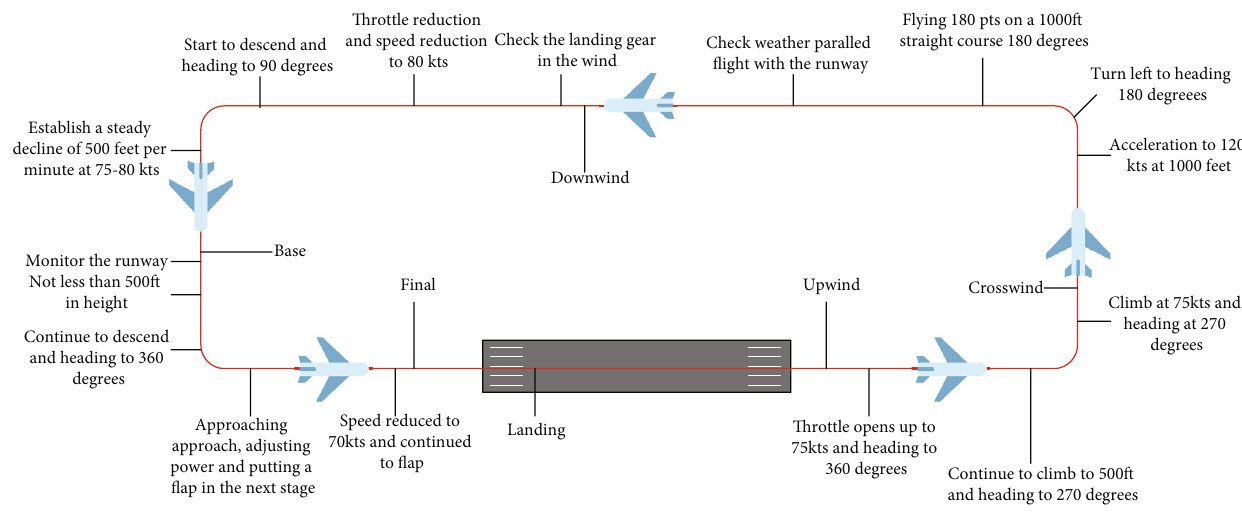
Figure 3: Flight diagram of the air fi eld tra ffi c